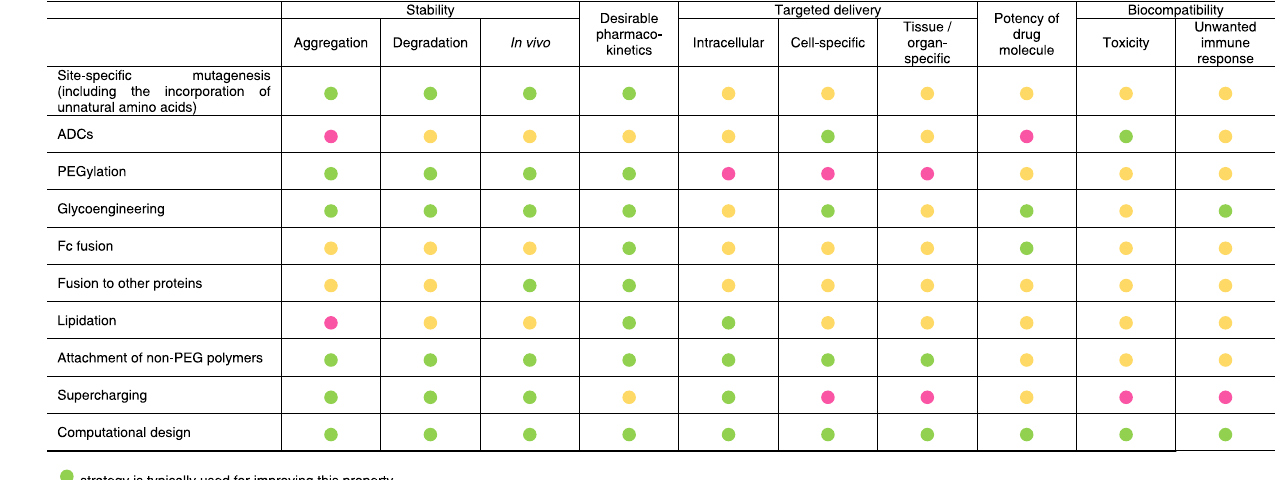
Table 1 | Structural and chemical design strategies and their impact on the properties of protein-based